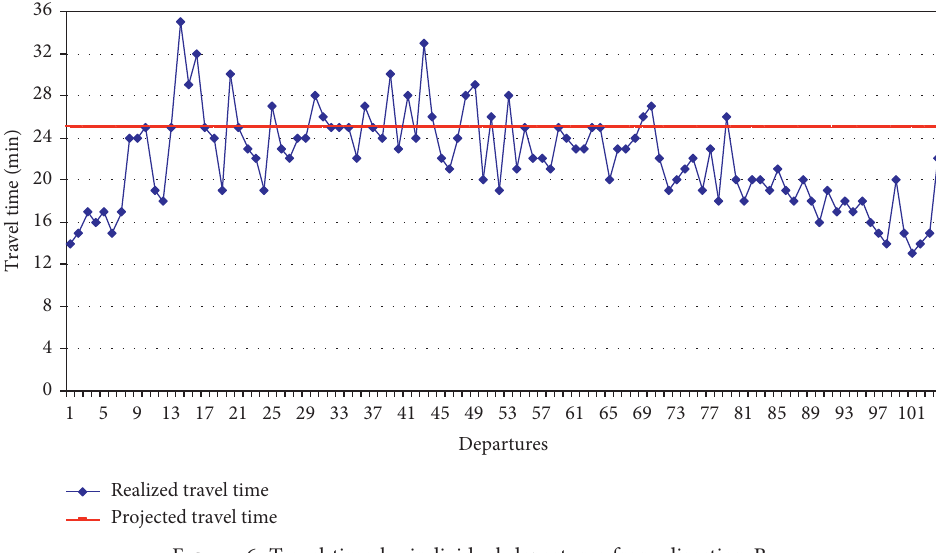
Figure 6: Travel time by individual departures from direction B.